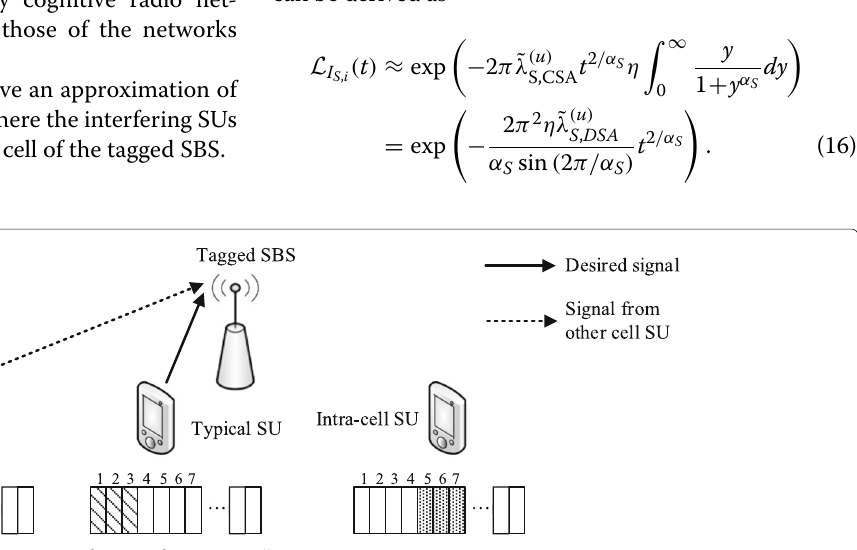
Fig. 2 When the CSA is employed, there are no interferences from intra-cell